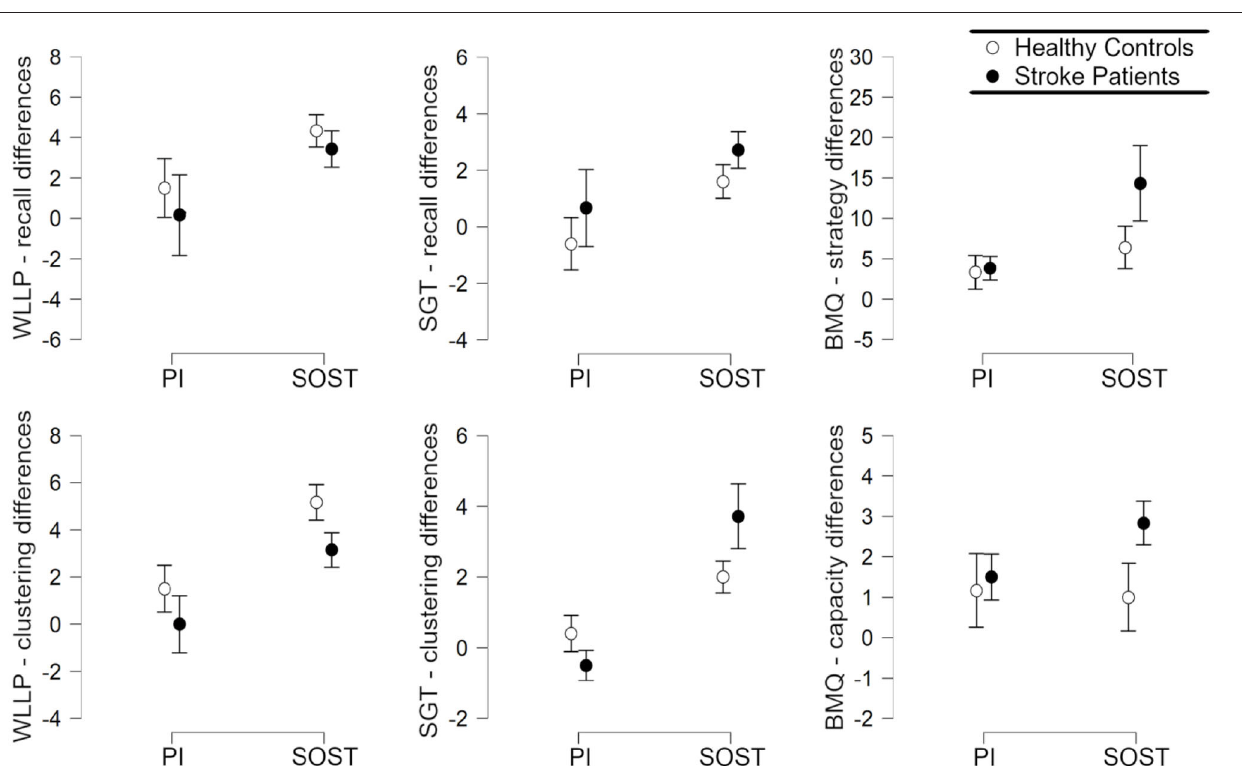
clustering score differences [ F (1,21) = 13.38, FDR-corrected p = 0.0044]. These results were produced by higher post vs. pre- intervention differences in SOST groups ( Figure 4